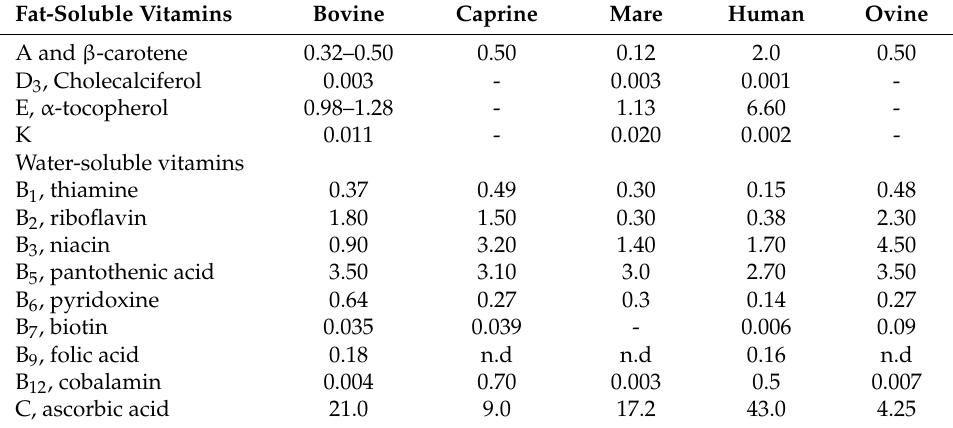
Table 3. Vitamin content (mg/L) in the milk of different species (adapted from [10]). Fat-Soluble Vitamins